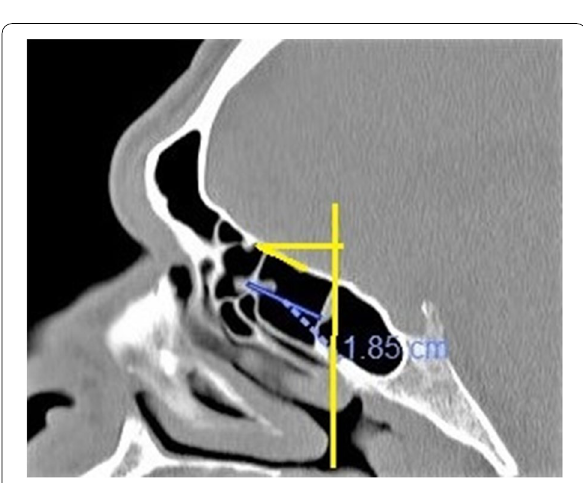
Fig. 3 Measurement of the degree of inclination of the posterior ethmoid